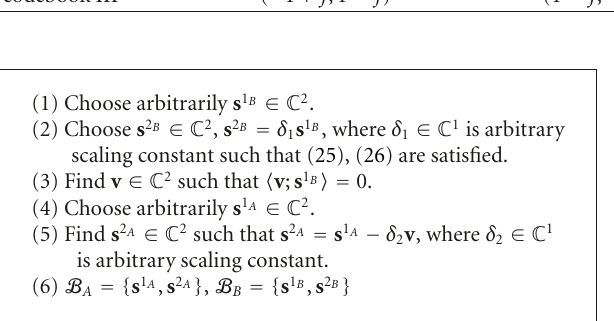
Algorithm 1: Binary E-PHXC codebook—example